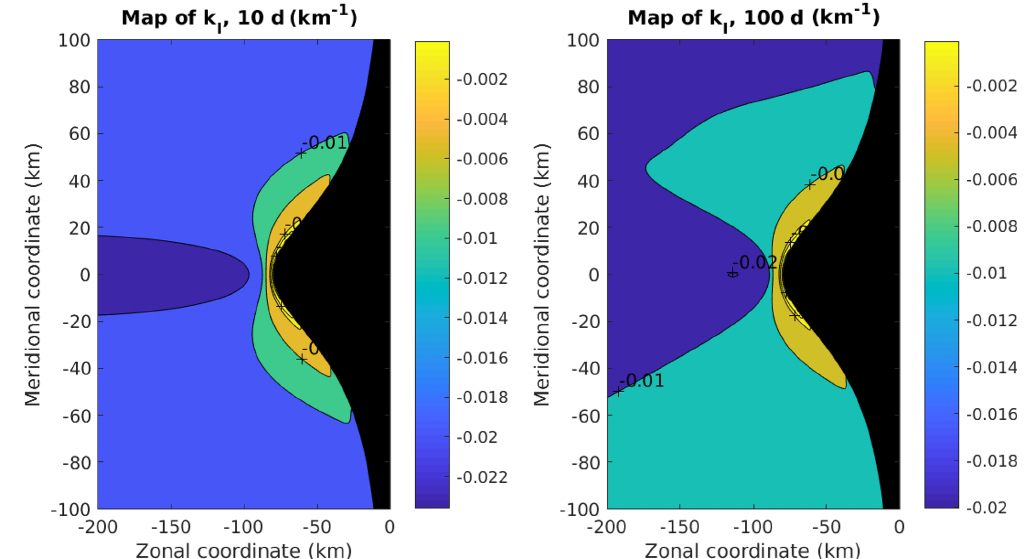
Figure 16. Coefficient k I for periods equal to 10 and 100d. This coefficient depends weakly on the period of the wave.